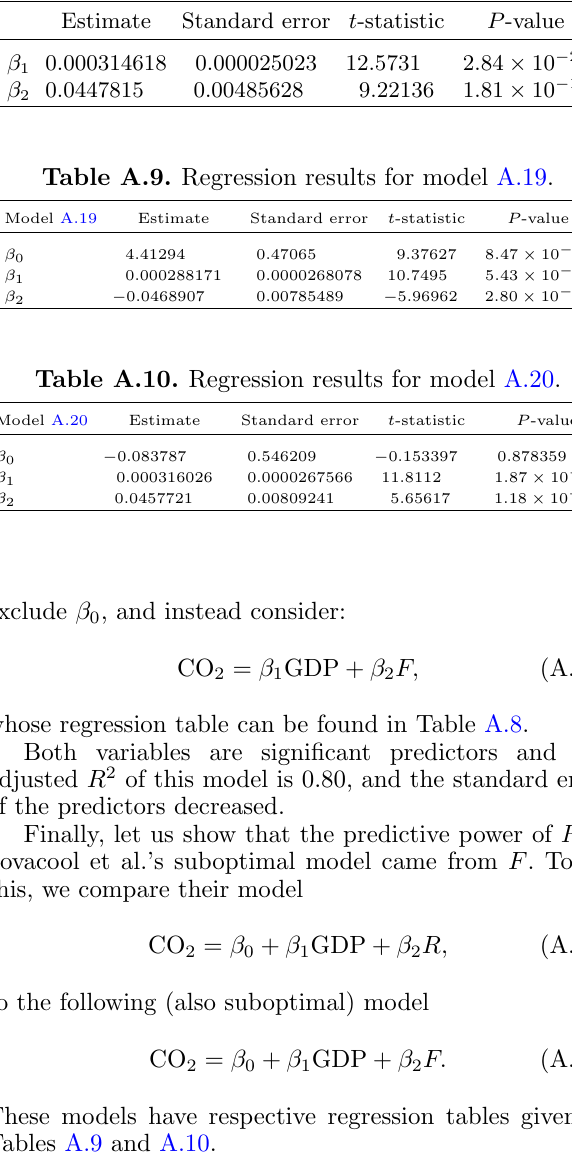
Table A.8. Regression results for model A.18.